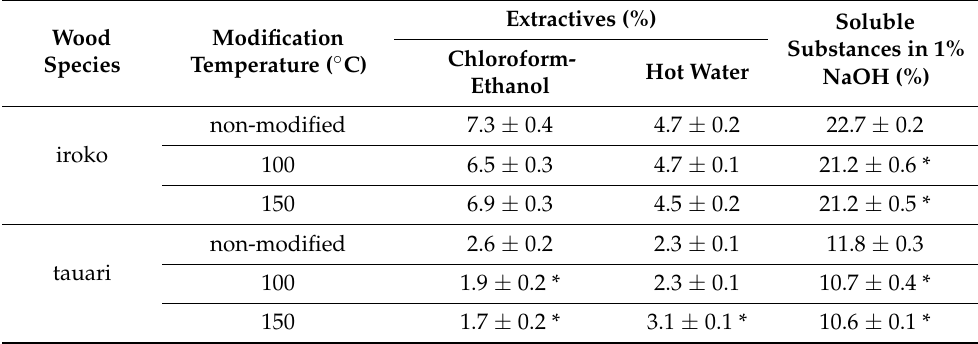
Table 3. The content of extractives and 1% NaOH soluble substances in thermo-mechanically modified iroko and tauari wood; ±